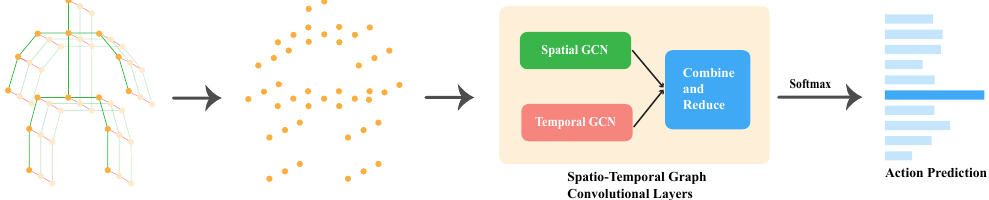
Figure 2. The end-to-end pipeline of